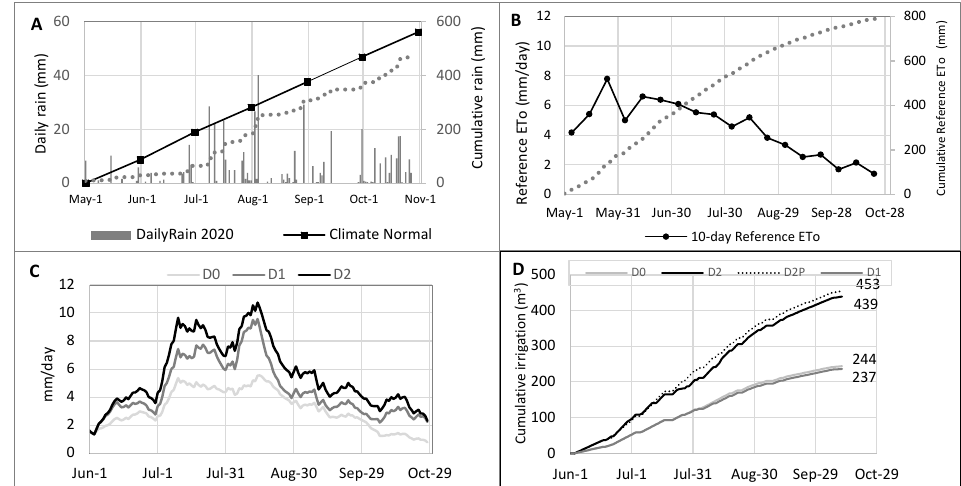
Figure 1. Irrigation parameters in 2020. ( A ) Daily rainfall quantities, cumulative rainfall, and 1980–2005 climate normal; ( B ) A 10-day moving average reference evapotranspiration (ETo) and cumulative ETo; ( C ) Modeled 10-day moving average of evapotranspiration; ( D ) Cumulative daily irrigation volumes (m 3 ) applied by treatment (corresponding to an irrigation area of 804 m 2 ).